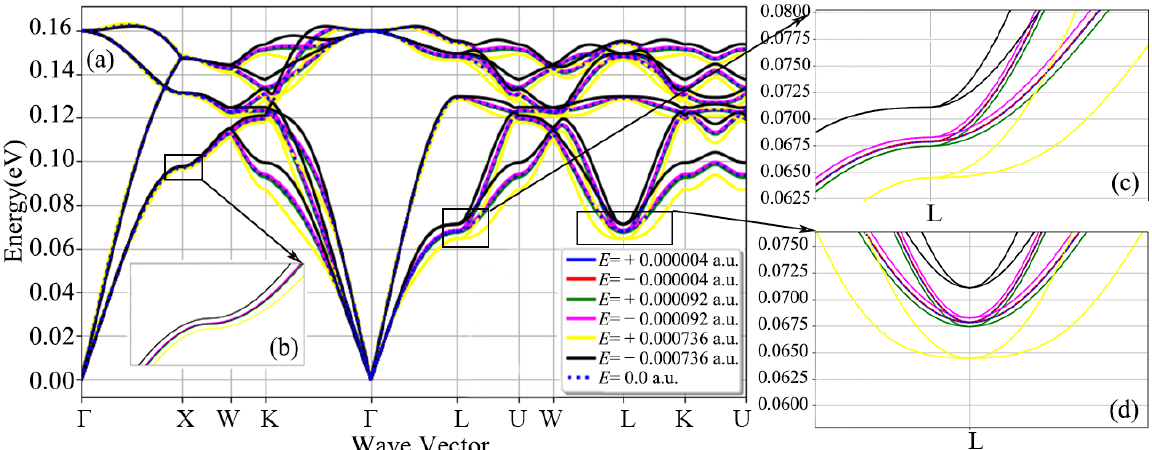
Figure 2. Phonon spectra of diamond primitive cells with fixed lattice structure and atomic positions after applying electric fields of different strengths in the [001] crystal direction: ( a ) full phonon dispersion along a high symmetry path, ( b – d ) are the phonon dispersion curve at point X and point L,